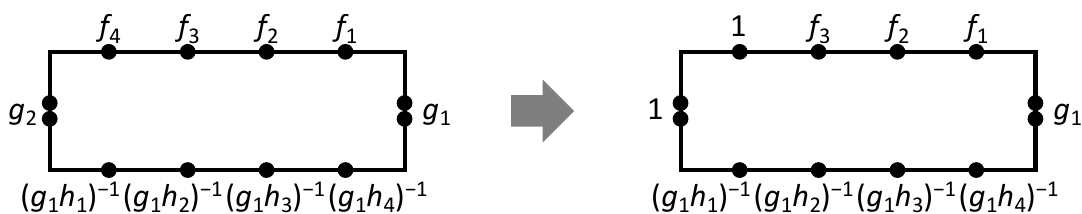
Figure 11 . Asymptotic values for the E 7 curve: the original asymptotic values (left) and the values after fixing the conditions in (A.22)